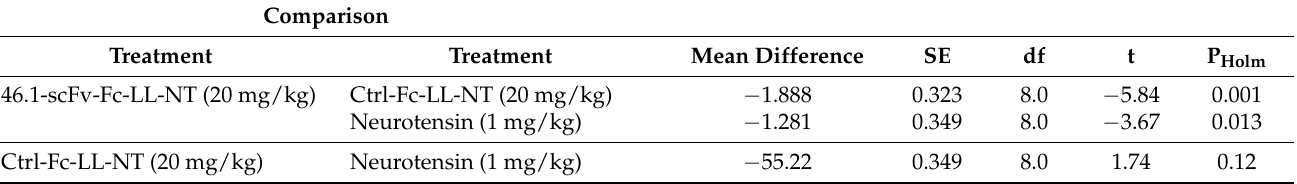
Table A2. The statistical parameters for the mixed ANOVA analysis of transient hypothermia.